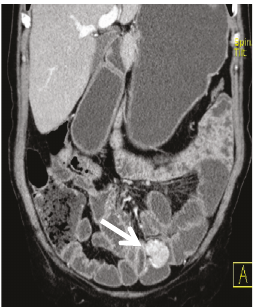
Figure 2: CT scan (no signs of lesions or intussusception).